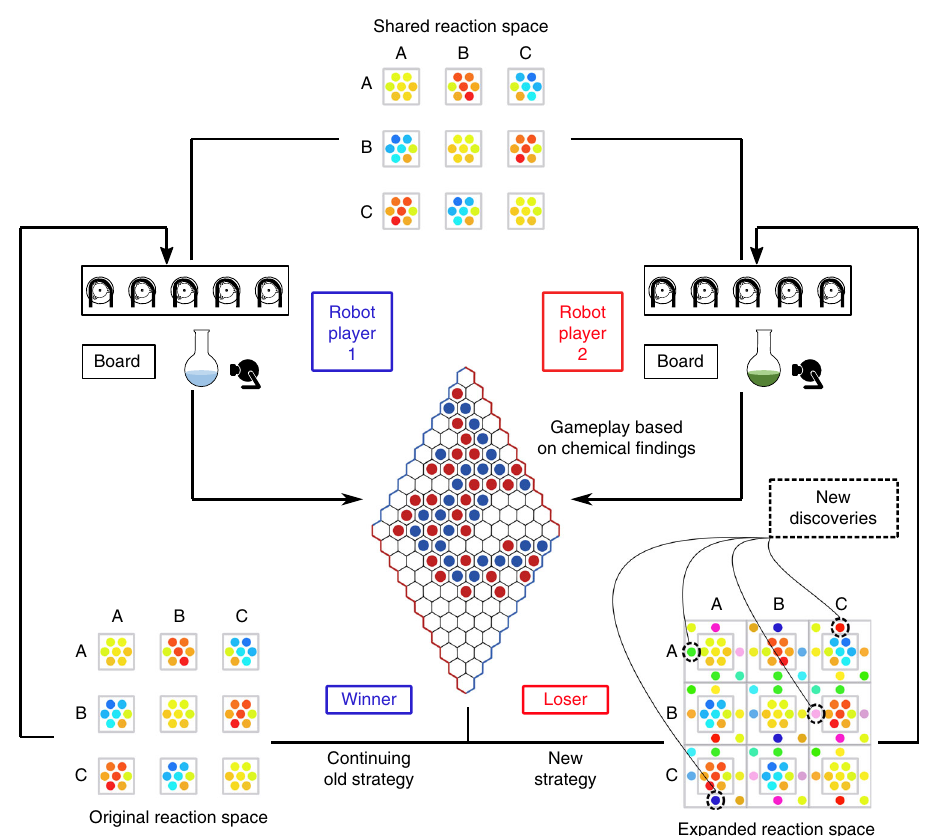
Fig. 7 Gameplay algorithm of player 1 vs player 2 in a series of Hex games. After the fi rst game is complete strategies of the winner and loser diverge to explore unknown chemical